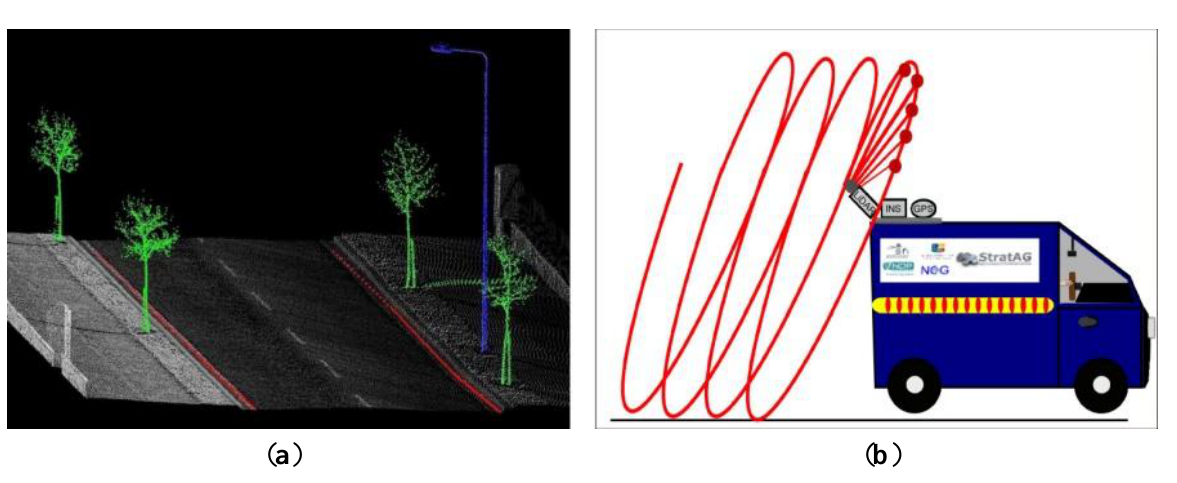
Figure 1. Data processing and point distribution ( a ) automated algorithms identify